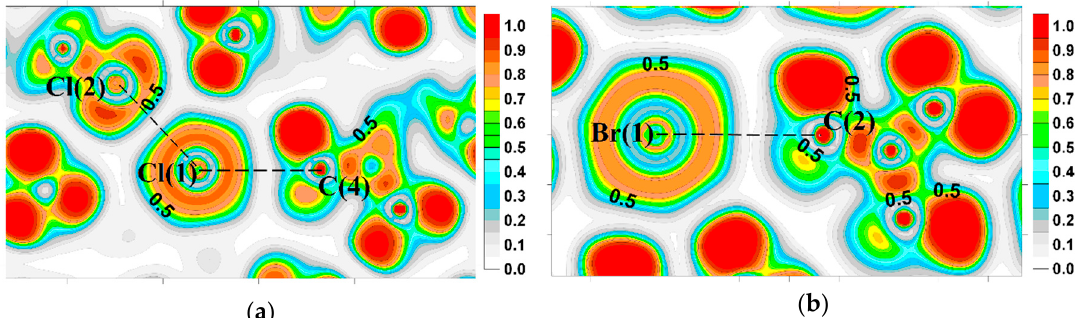
Figure 4. The ELF for ( a ) the halogen and tetrel bonds Cl(2) ··· Cl(1) − ··· C(4) in LONGEB crystal; ( b ) the tetrel bond in LILLOH crystal.